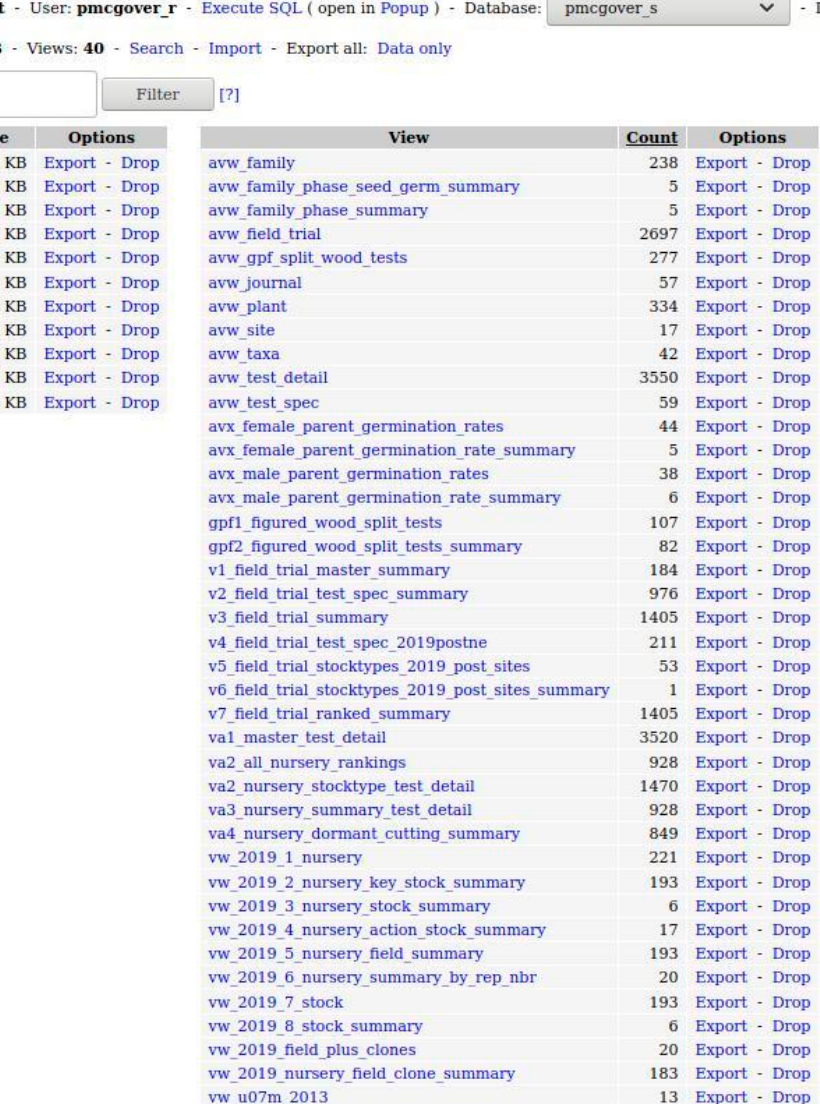
Figure 1. The Open4st Online Database: Table and View Listing.